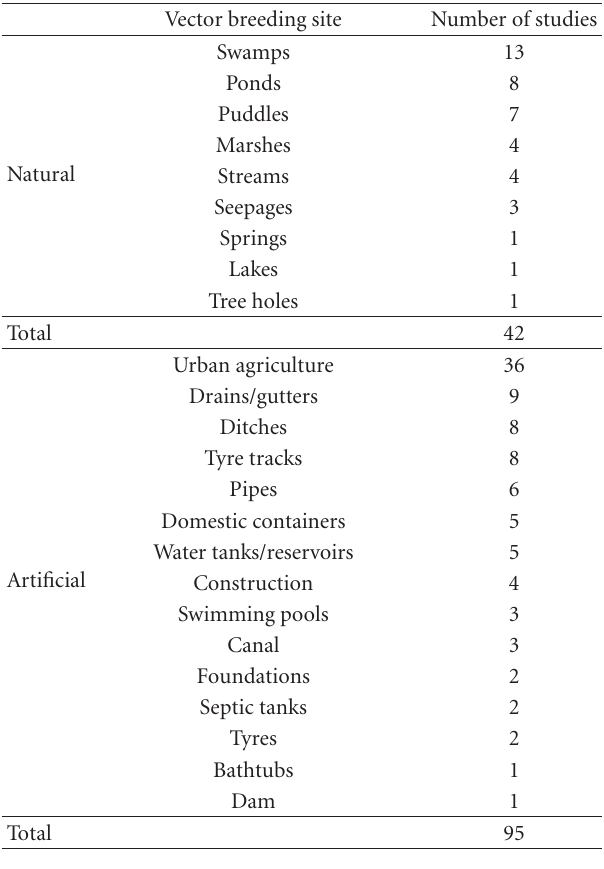
Table 2: Urban vector breeding sites by number of citations. Vector breeding